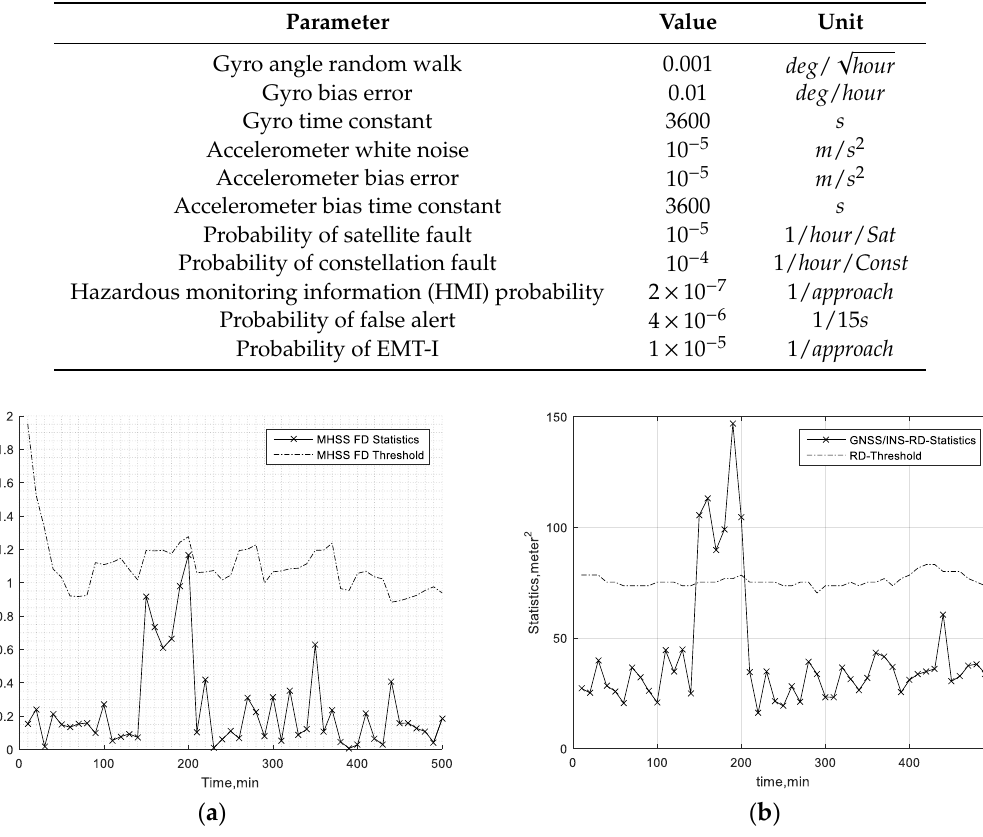
Table 3. Inertial navigation system (INS) and global navigation satellite system (GNSS) simulation conditions.